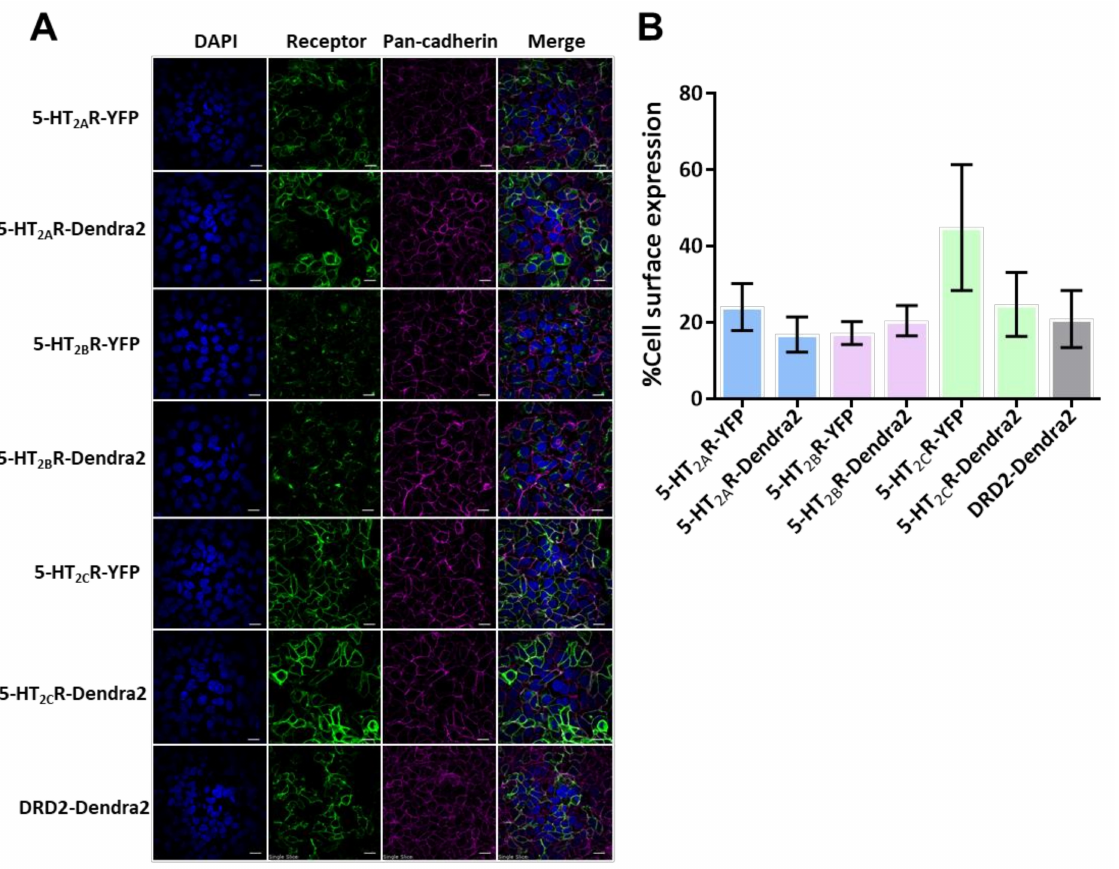
Figure 1. Cell-surface characterization of 5-HT 2 R-Dendra2 protein compared to 5-HT 2 R-YFP in stable cell lines. ( A ) Representative images of stably-expressing 5-HT 2 Rs-YFP, 5-HT 2 Rs-Dendra2, and DRD2- Dendra2 constructs (green) in HEK293A cells, by confocal microscopy using a 60 × objective lens (1.45 NA). Pan-cadherin (cell-surface marker) expression is shown in magenta, receptor in green and DAPI (nuclei) in blue. Scale bar = 10 µ m. ( B ) Cell-surface expression levels for 5-HT 2 R subtypes and DRD2-Dendra2 compared to 5-HT 2 R subtypes-YFP were measured. Analysis was performed by quantifying Manders’ colocalization coefficient by measuring the percent colocalization of receptor expression with the pan-cadherin antibody (as surface marker) using ImageJ software. Percent cell-surface expression is averaged from at least 10 fields of view in three independent experiments. Error bars =